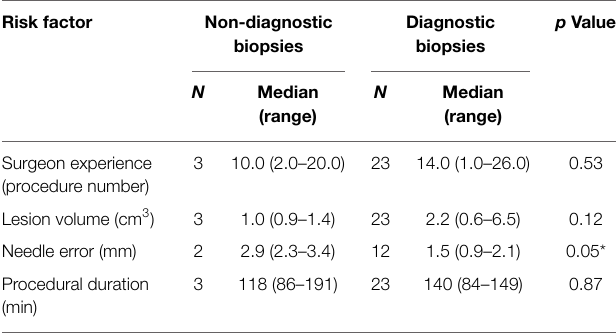
TABLE 3 | Analysis of continuous risk factors associated with obtaining a non-diagnostic stereotactic brain biopsy . Risk